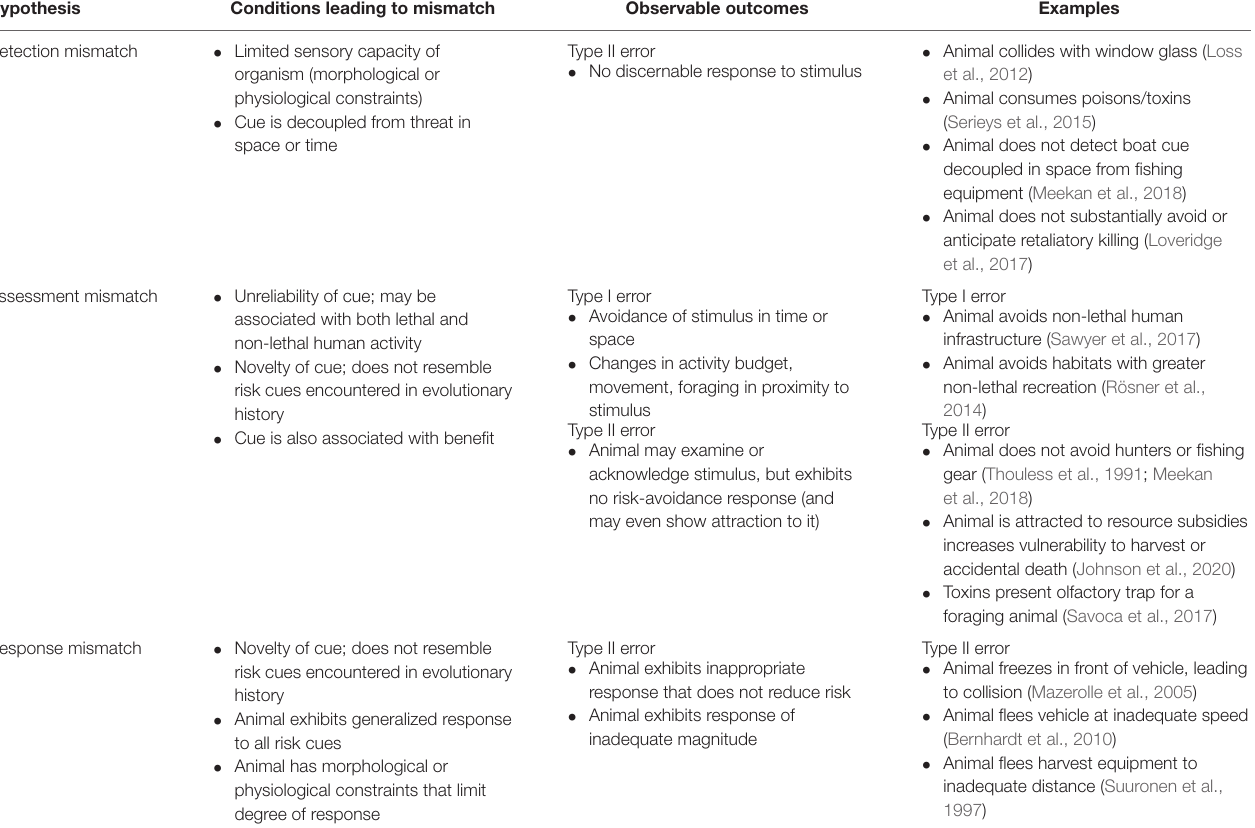
TABLE 1 | Predicted responses to anthropogenic stimuli associated with three alternative hypotheses for risk-response mismatch.